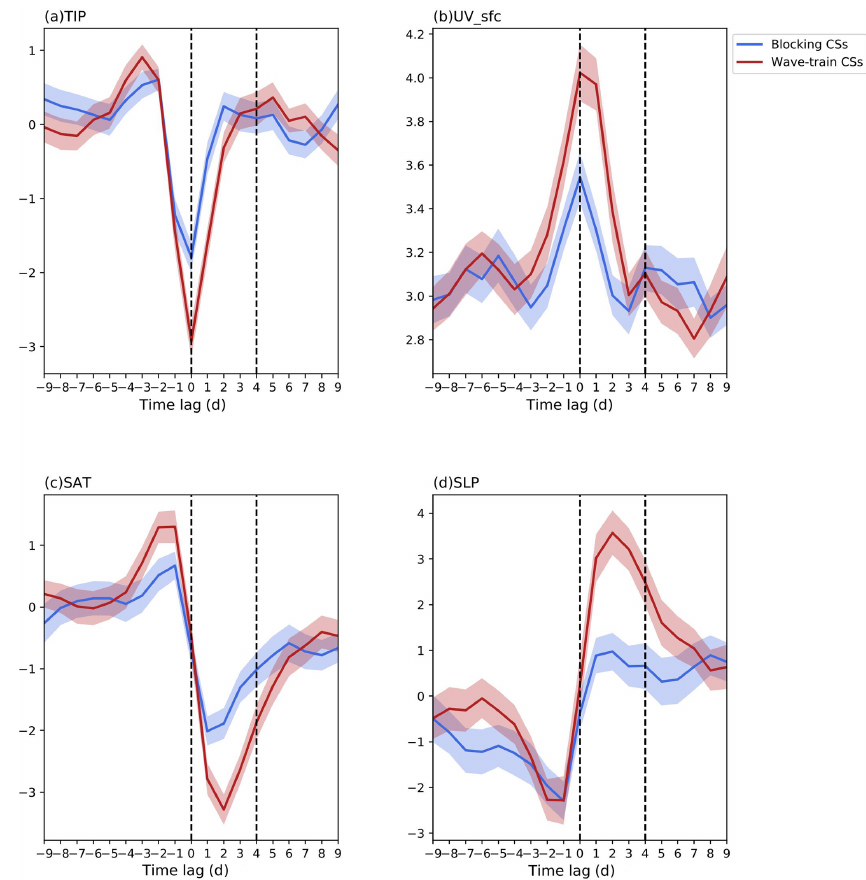
Figure 6. Regional averaged (a) TIP anomalies (K), (b) UV_sfc anomalies (ms − 1 ), (c) SAT anomalies (K), and (d) SLP anomalies (hPa) over EC during 9d before and after the outbreak of the blocking CSs (blue lines) and wave-train CSs (red lines), respectively. Shading represents ± 1 standard deviation among the